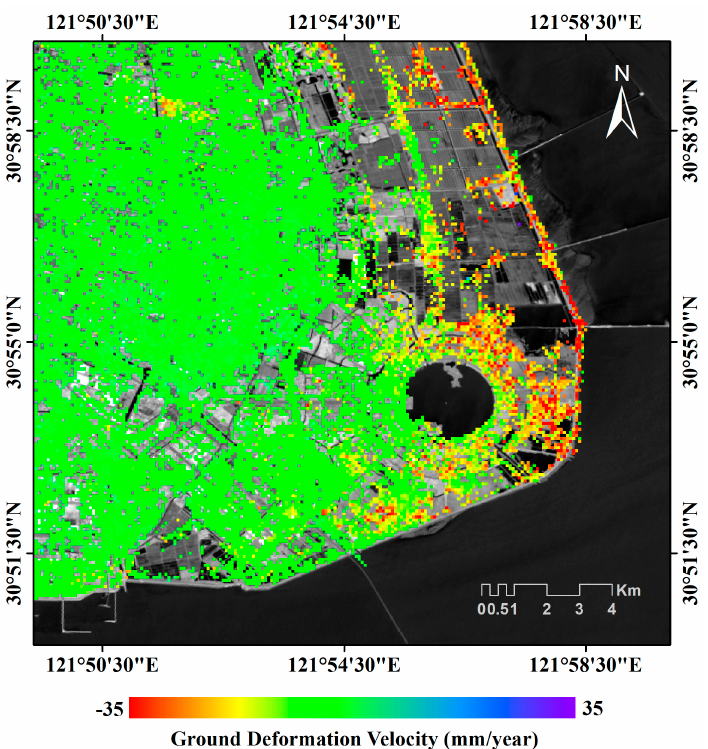
Figure 7. Map of the mean (vertical) deformation velocity from 2007 to 2016 Lingang New City, as retrieved by combining the time-gapped ENV and CSK LOS displacement time-series.